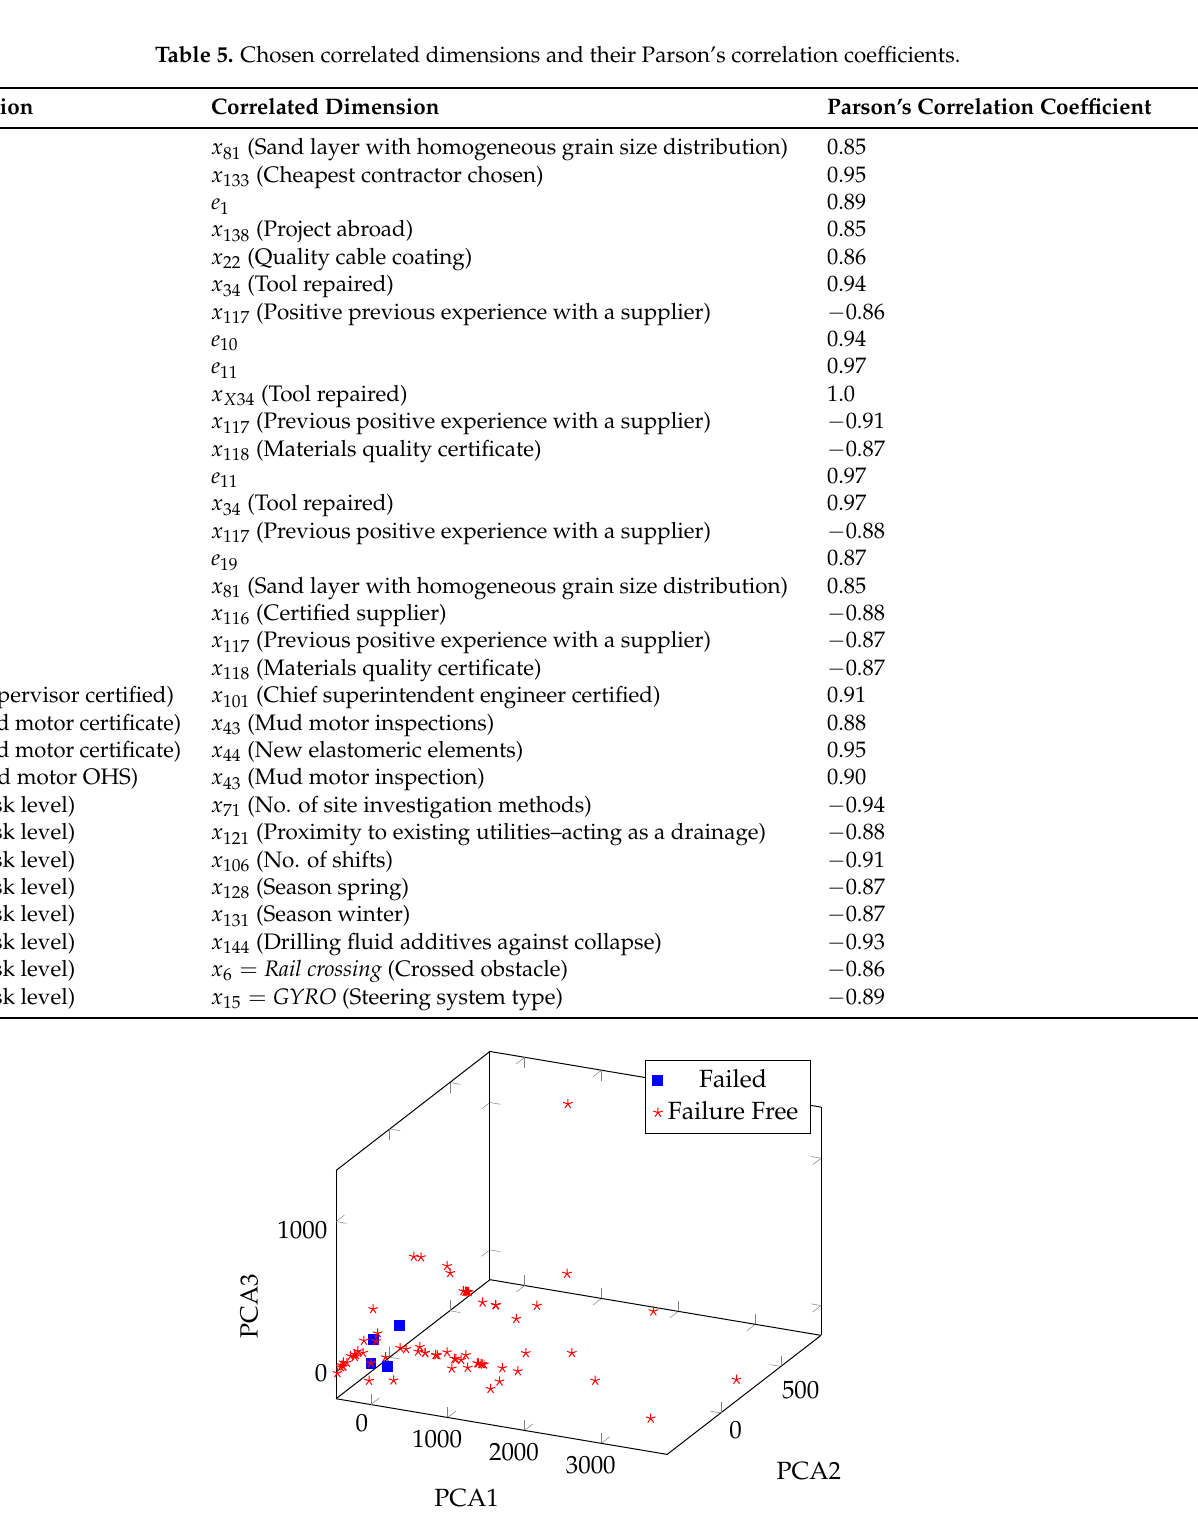
Figure 6. The results of PCA analysis for the whole data